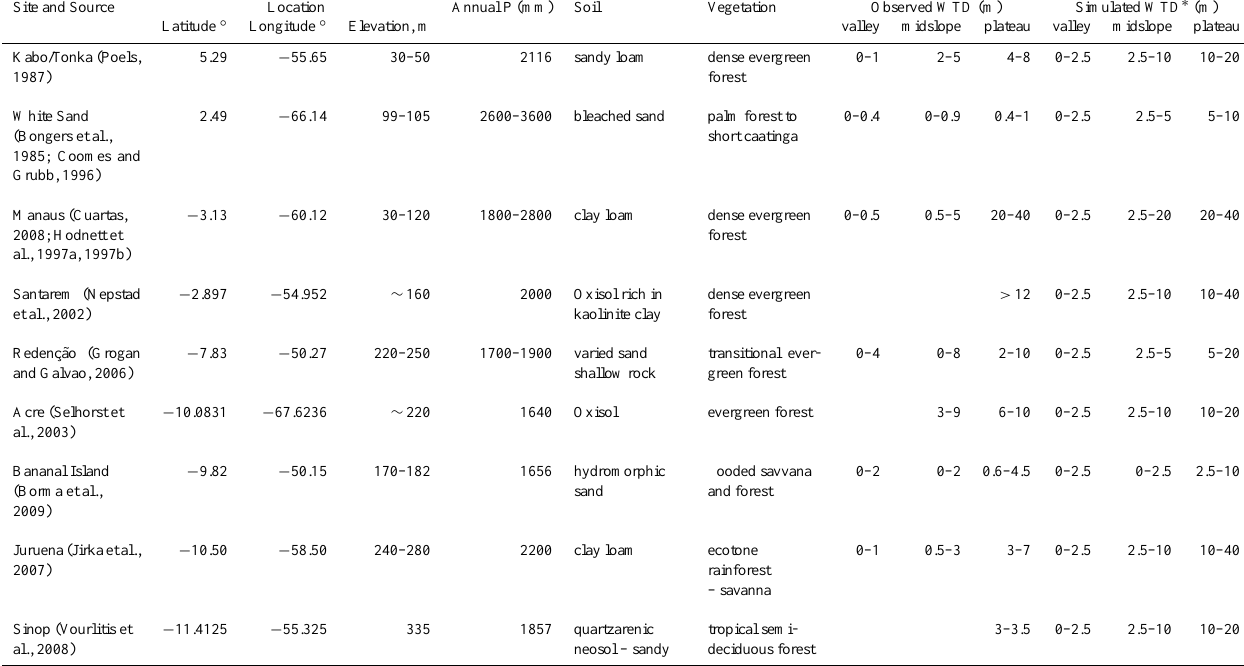
Table 3. Information on the 9 sites for detailed validation and comparison between observed and simulated WTD (forced by